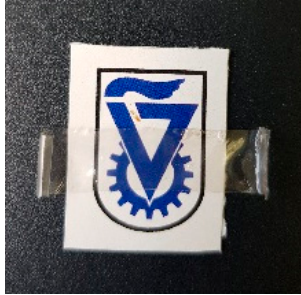
Figure 1. Water soluble cellulose acetate film.